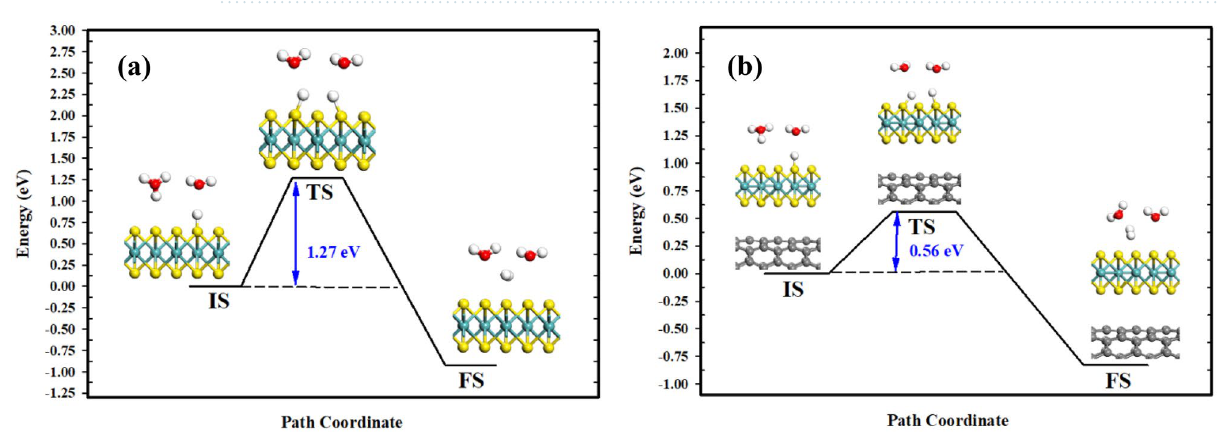
Figure 7. Minimum-energy pathway of the Tafel reaction on: ( a ) MoS 2 ; and ( b ) the MoS 2 /CNT heterostructure. BIOVIA, Dassault Systèmes, Materials Studio, version 7. https ://bit.ly/38lRR